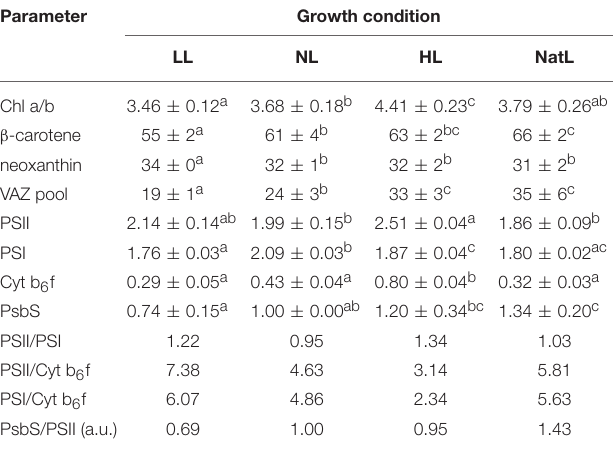
TABLE 2 | Pigment and protein composition. Parameter Growth